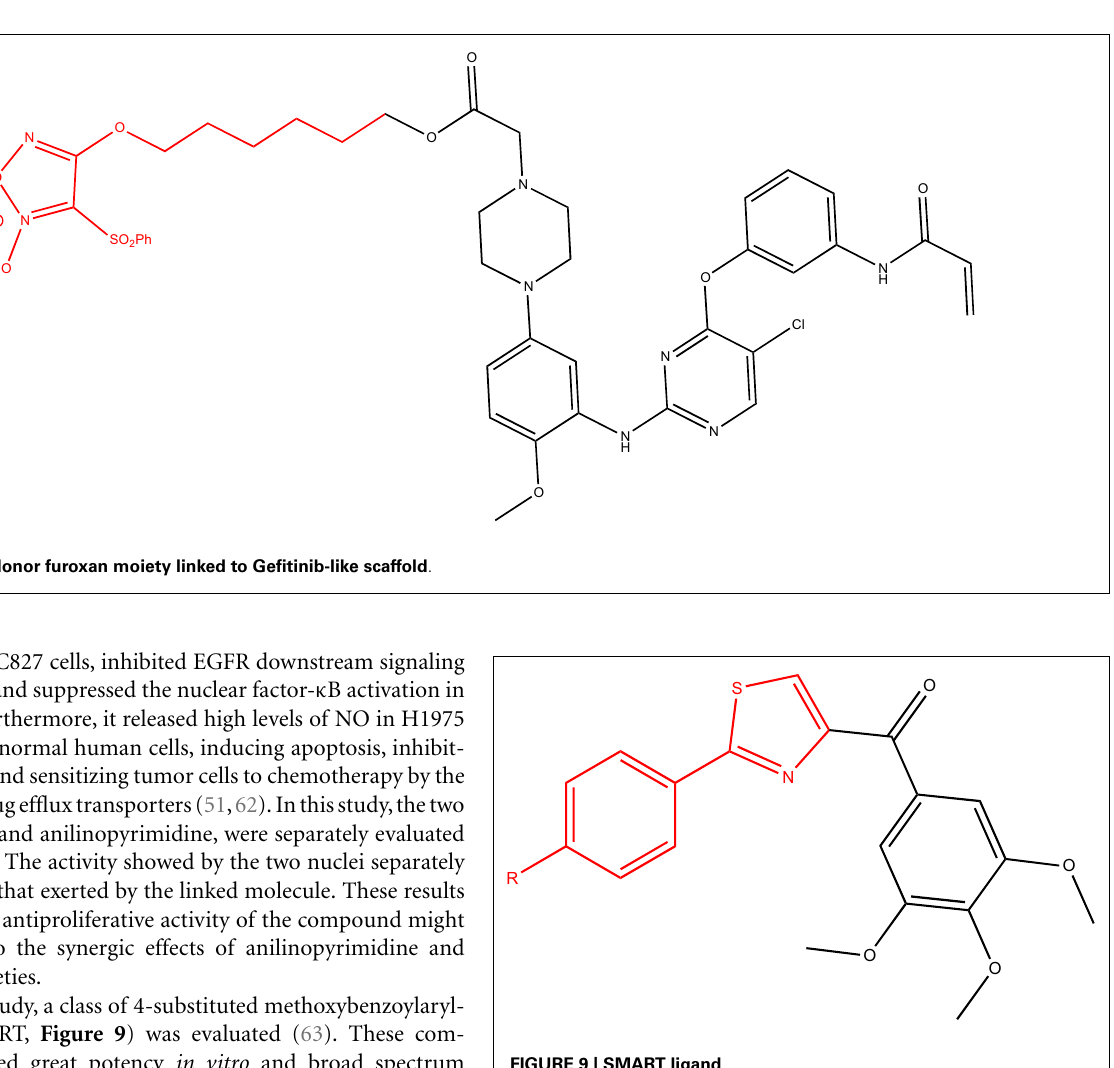
FIGURE 9 | SMART ligand